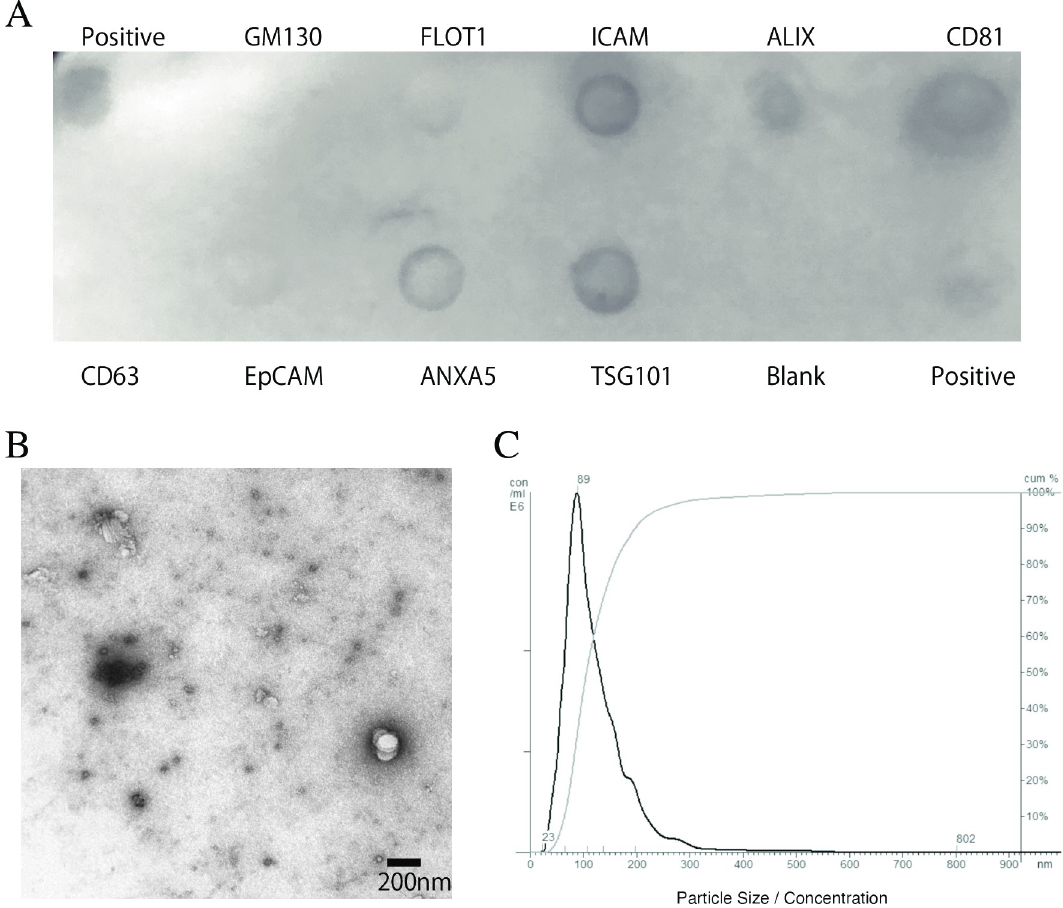
Fig 1. Identification and morphological characterization of exosomes. Exosome isolation was confirmed via immunoblotting using the Exo-Check Antibody Array, a transmission electron microscope, and nanoparticle tracking analysis. ( A ) The exosome compartments of the samples were placed in the pre-printed spots of eight antibodies against known exosome markers (FLOT1, ICAM, ALIX, CD81, CD63, EpCAM, TSG101, and ANXA5), in the positive control, and in the blank (negative control) to examine the presence of exosome-specific proteins. ( B ) Representative images from transmission electron microscopy showing typical exosome cup-shaped morphology. ( C ) The size distribution (black line) and cumulative distribution (gray line) of the exosomes were measured using the nanoparticle tracking